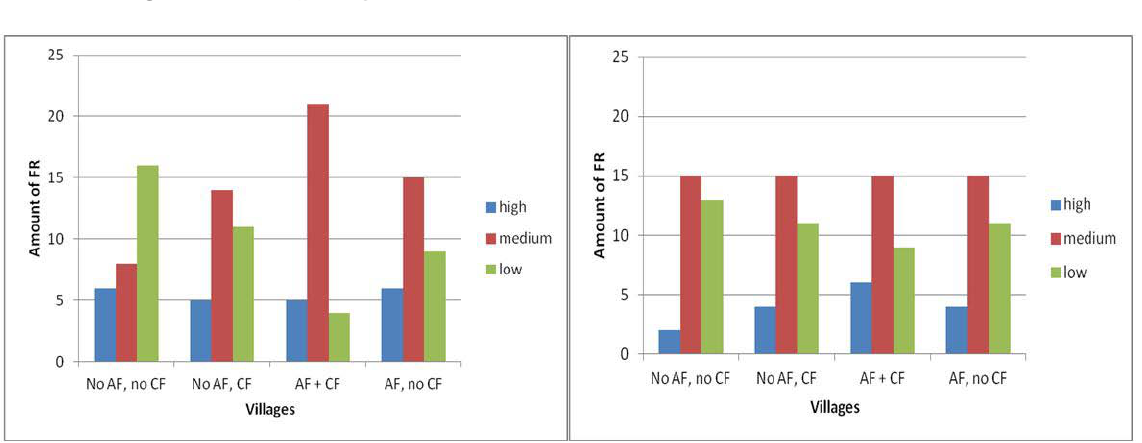
Figure 4. Comparing clustered first round and second round